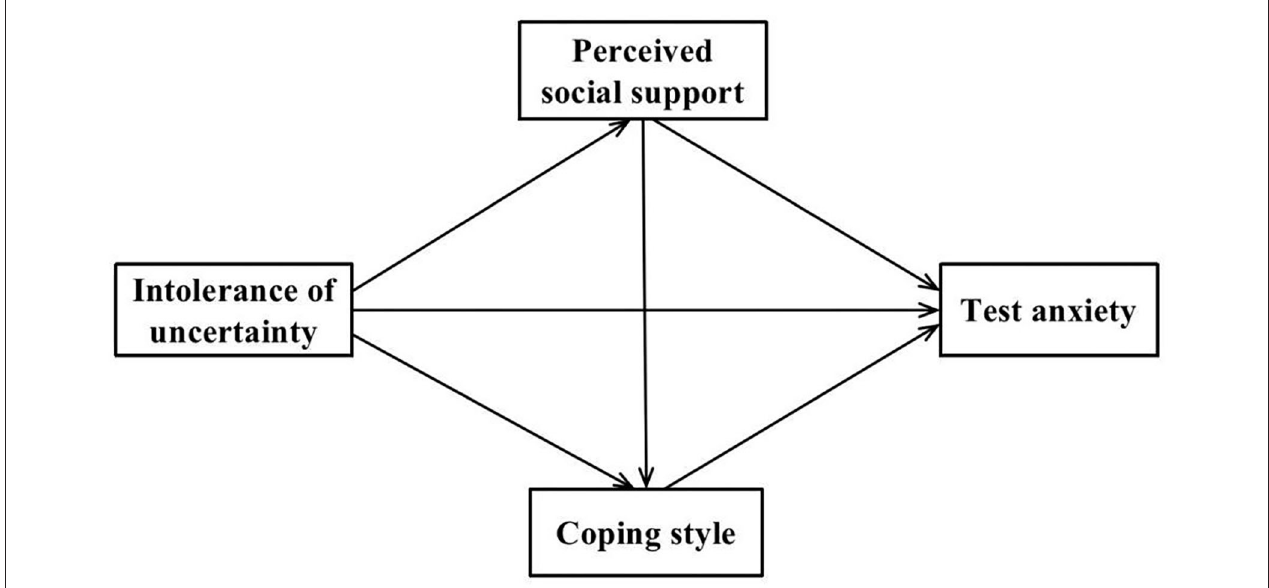
FIGURE 1 | The hypothesized mediation